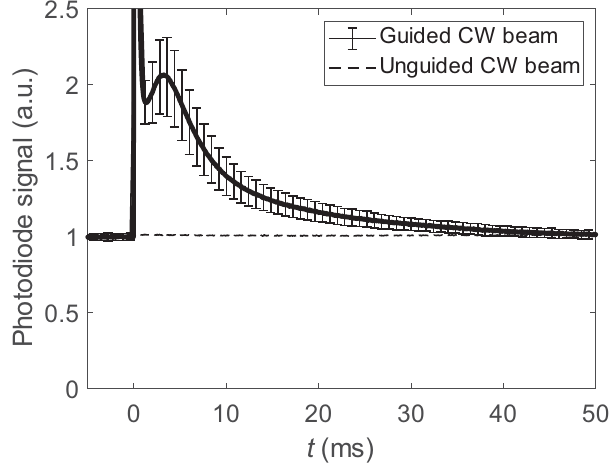
FIG. 10. Measurement of the guiding of a CW probe beam in an approximately 45-m waveguide. A 100-mW, λ ¼ 532 -nm laser diode is injected into the waveguide through the down-collimation telescope mirror [see Fig. 2(b)] into the waveguide and then collected by an integrating sphere at z ¼ 45 m. The waveguide lifetime is directly read off the signal to be tens of milliseconds. Solid curve: 100-shot average. Error bars: (cid:3) standard deviation. The first peak is filament-generated supercontinuum collected by the integrating sphere, and the second peak reflects maximum guiding efficiency at approximately (3 – 5)-ms